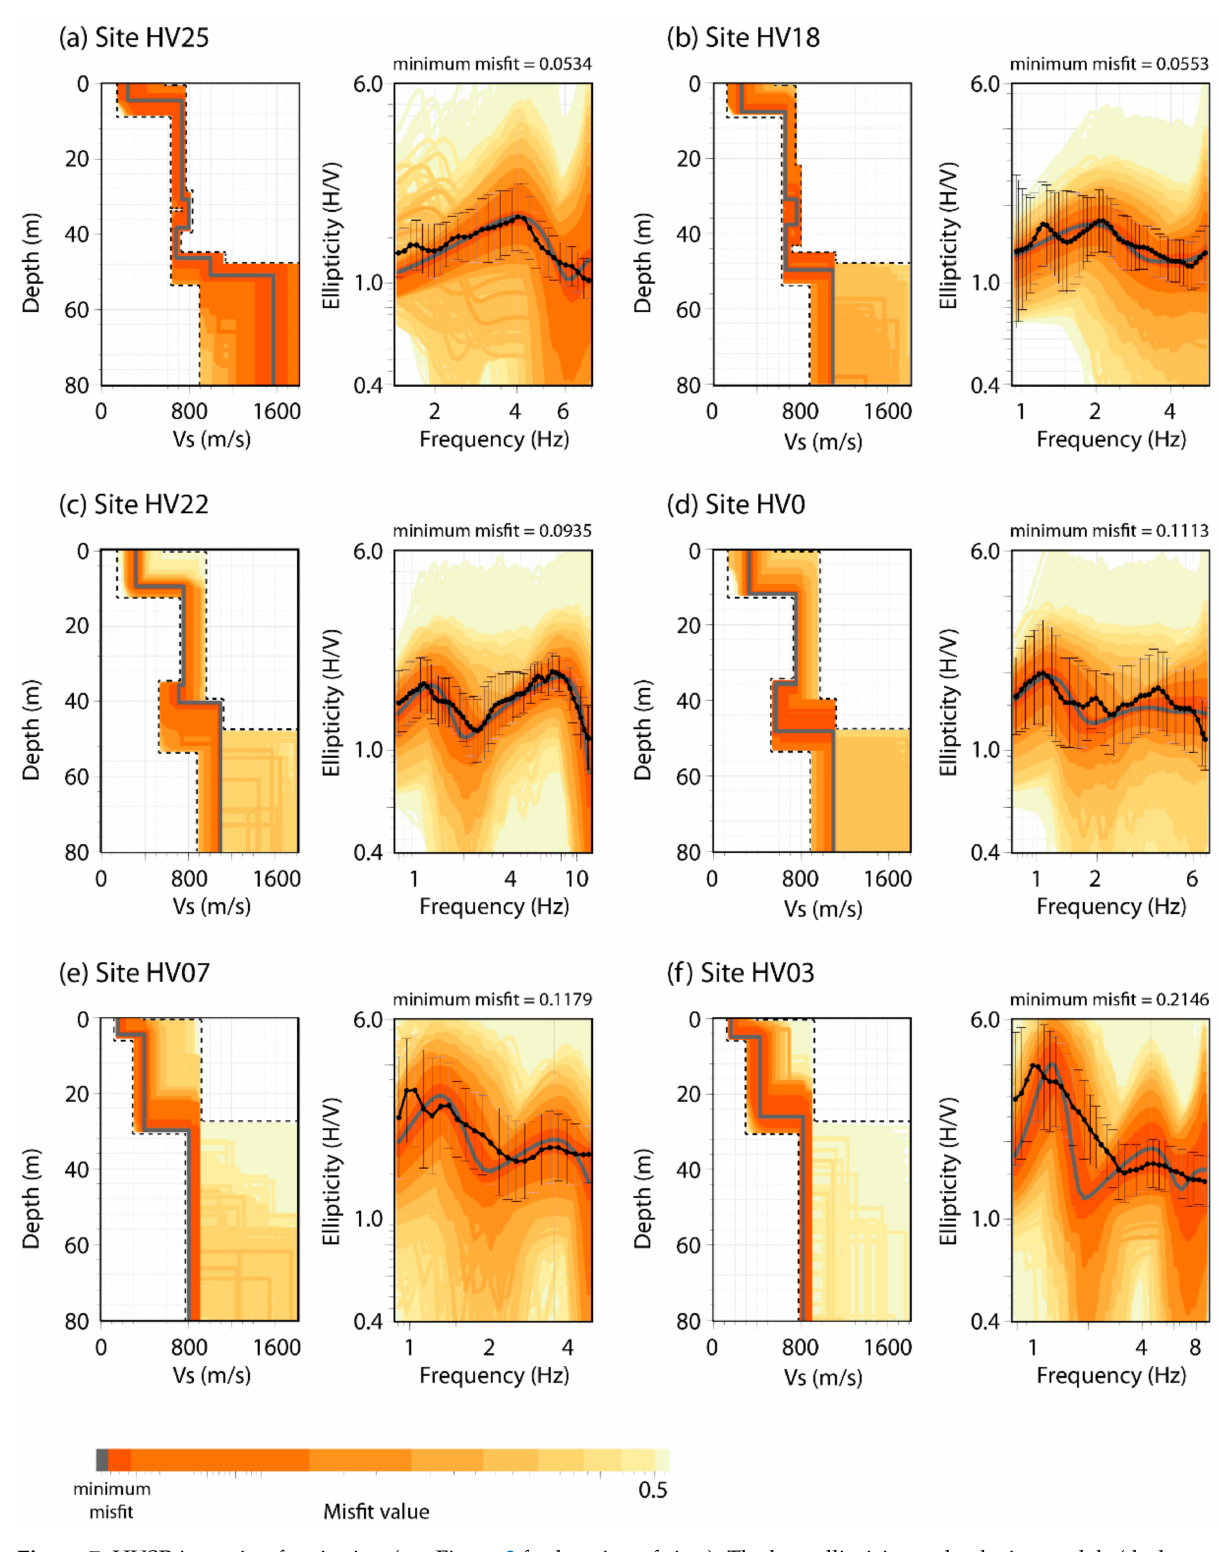
Figure 7. HVSR inversion for six sites (see Figure 3 for location of sites). The best ellipticity and velocity models (dark grey lines), together with models lying inside the minimum misfit + 10% (dark orange) and all the tested models, are shown. The black curve and bars in the ellipticity plots are the average and standard deviation, respectively, of the experimental HVSR curve. The dashed lines in the velocity profiles indicate the search